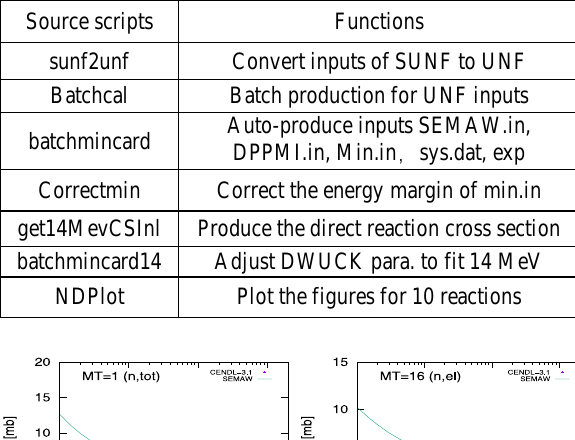
Table 2. The source codes in the FP evaluation system.